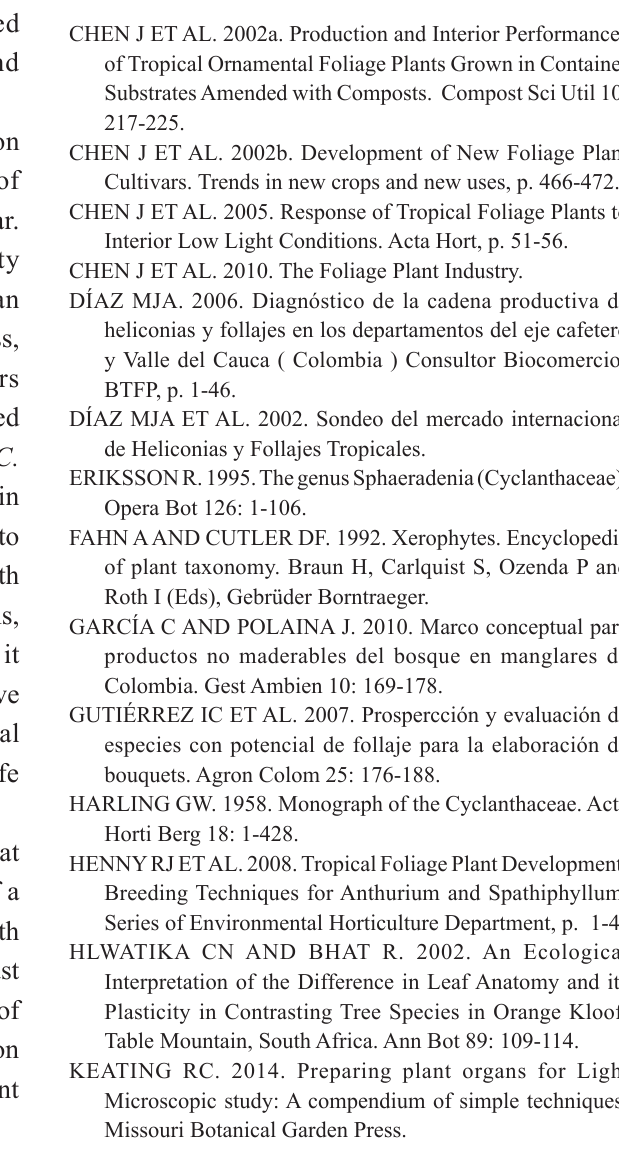
Table Mountain, South Africa. Ann Bot 89: